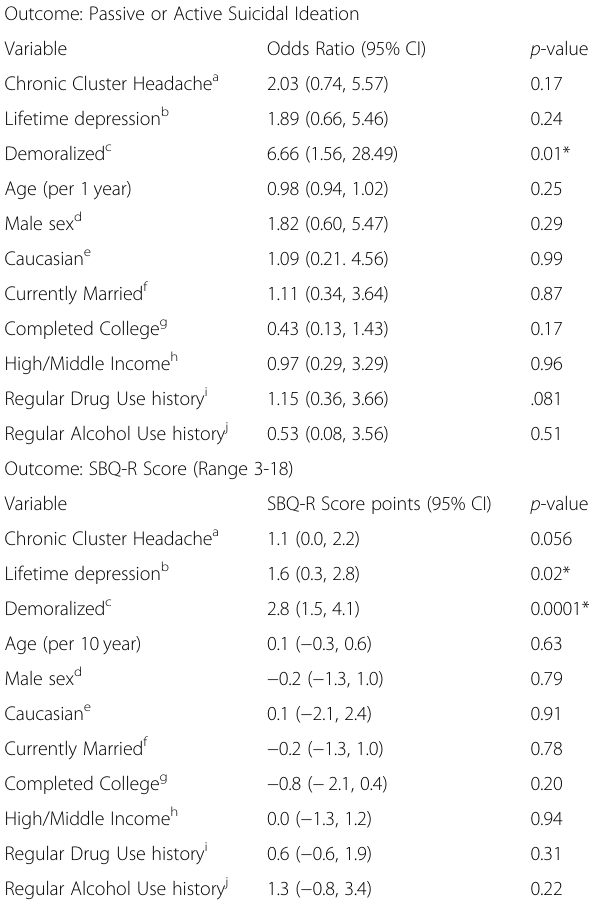
Table 5 Associations of Suicidal Ideation and High Suicide Risk in Cluster Headache